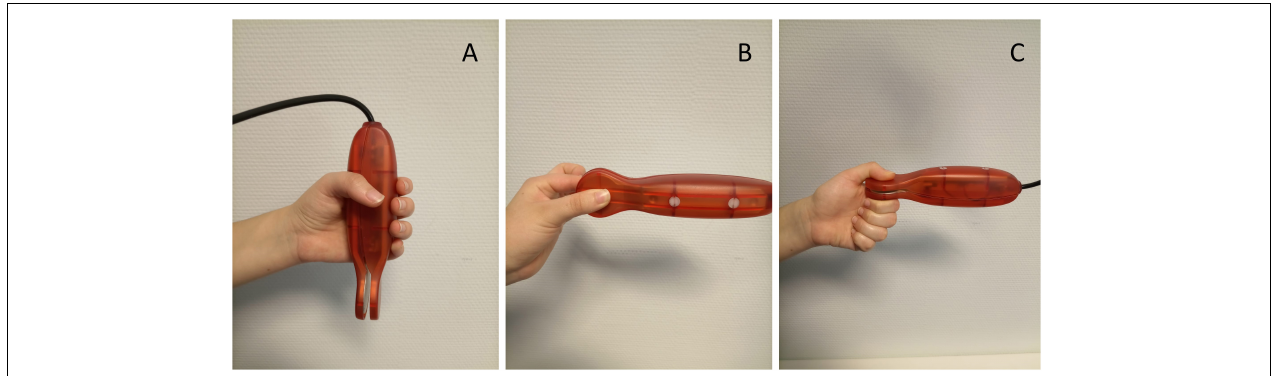
FIGURE 1 | Electronic dynamometer (NedVEP/IBV) functional positions: (A) handgrip, (B) lateral/key pinch (thumb pad and lateral aspect of index finger), (C) tip pinch (thumb opposed by the index and long fingers).